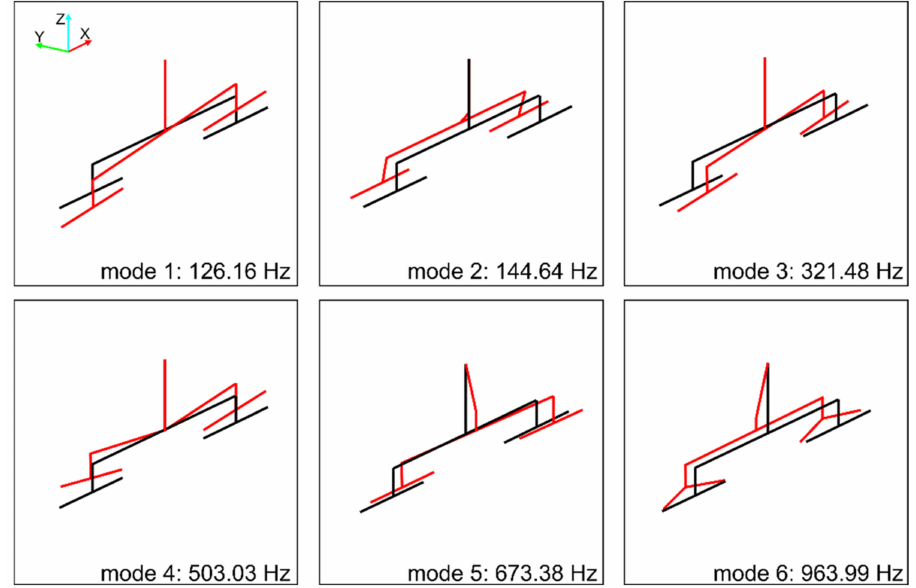
Figure 9. Normal modes of vibration of a boring tool determined by the calculation